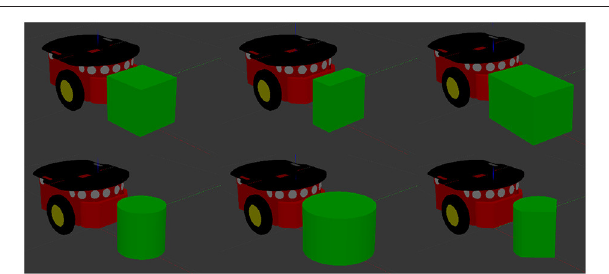
applied to. Moving clockwise from top left: a cube with sides of length 20 cm , a rectangular prism with dimensions 10 × 20 × 20 cm , a rectangular prism with dimensions 30 × 20 × 20 cm , a cylinder of height 20 cm and radius 10 cm , a cylinder of height 20 cm and radius 15 cm , and a hybrid object formed of half a cylinder and a triangular prism amounting to dimensions of 20 × 20 × 20 cm .